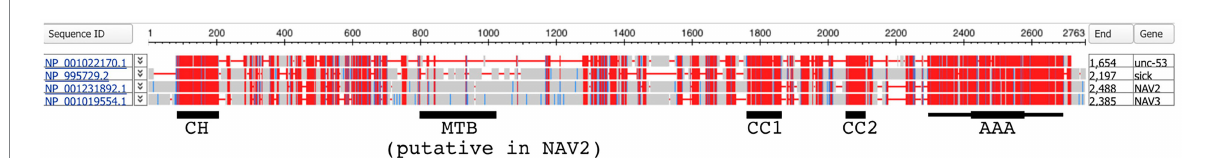
FIGURE 3 Alignment and conservation of protein sequences for Unc-53 isoform c, Sickie isoform B, hNAV2 isoform 5, and hNAV3 isoform 1. Highly conserved sequences are indicated in red, less conserved sequences in blue, and non-conserved sequences in gray. Conservation is based on the relative entropy threshold of residues, and does not indicate amino acid identity. Highly conserved sequences were observed for CH, CC1, CC2, and AAA+ domains. For AAA+ domains, the thick line indicates the NTPase core, and the thin line indicates the presumed entire domain. The putative microtubule-binding domain (MBD); also called the cytoskeletal-interacting domain) defined by deletion analysis of hNAV2 (Muley et al., 2008) was not conserved across NAV family proteins.